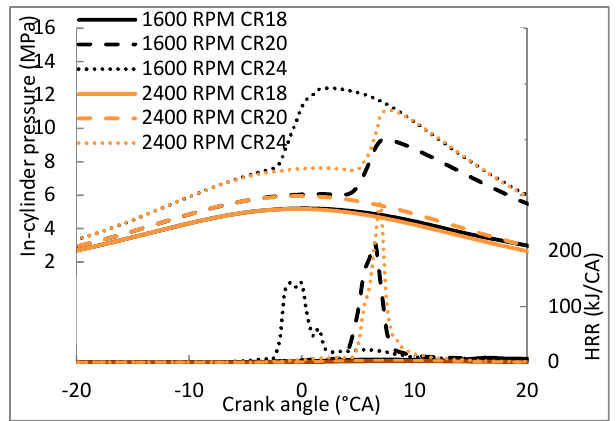
Figure 13. In-cylinder pressure and HRR graph of the D50E40B10 blend against a crank angle by using different engine compression ratios at different engine speeds.